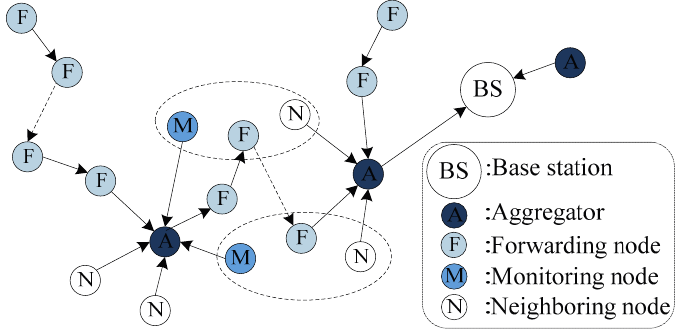
Figure 2. The network structure of FESA, where the three nodes within a dotted line are in the same group and share one group key. Algorithm 2 The formation of network